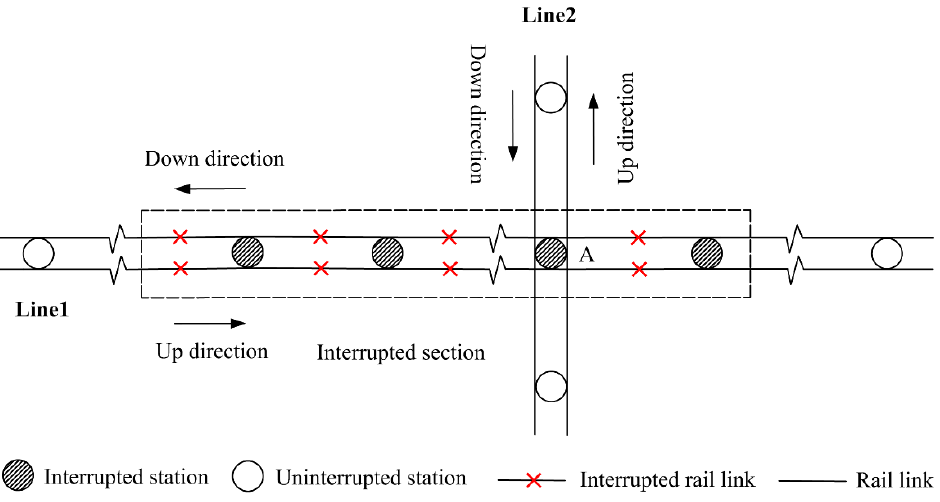
Figure 1. Illustrative example of URT service disruptions.